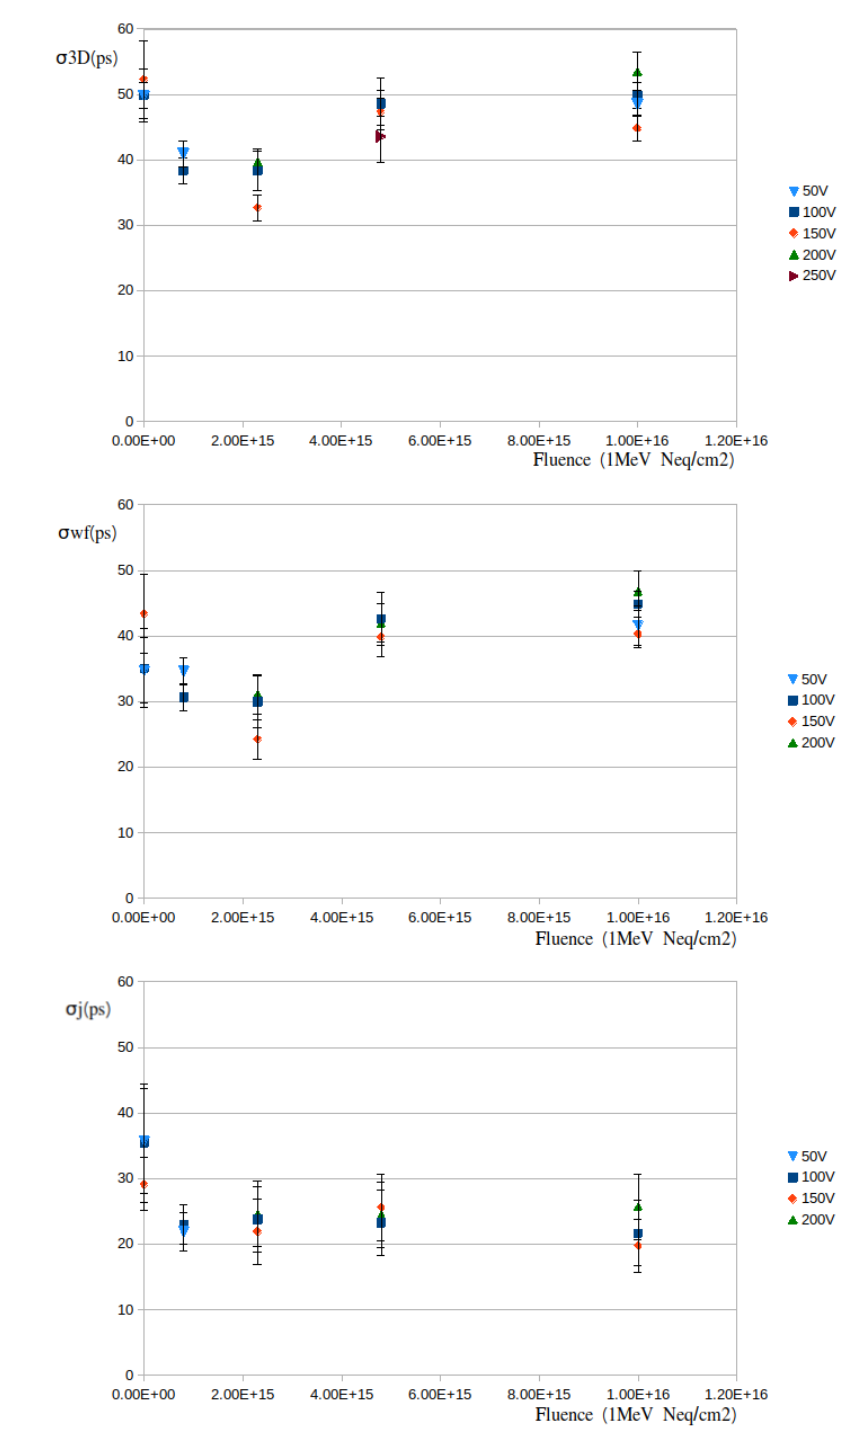
Figure 8. Time resolution vs. fluence for different bias voltages at − 20 °C. Top : σ 3 D , middle : σ wf , and bottom : σ j